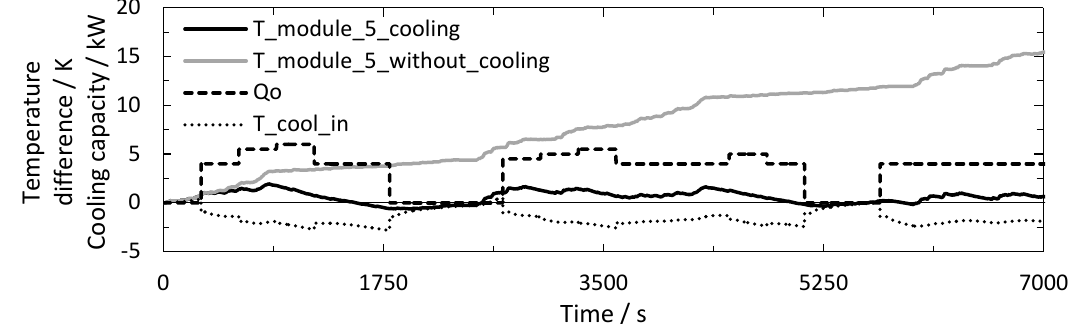
Figure 16. Coolant temperature, coolant capacity, and controlled and uncontrolled mean battery cell temperature of module 5 for two times line 84. The temperature difference refers to the initial conditions.